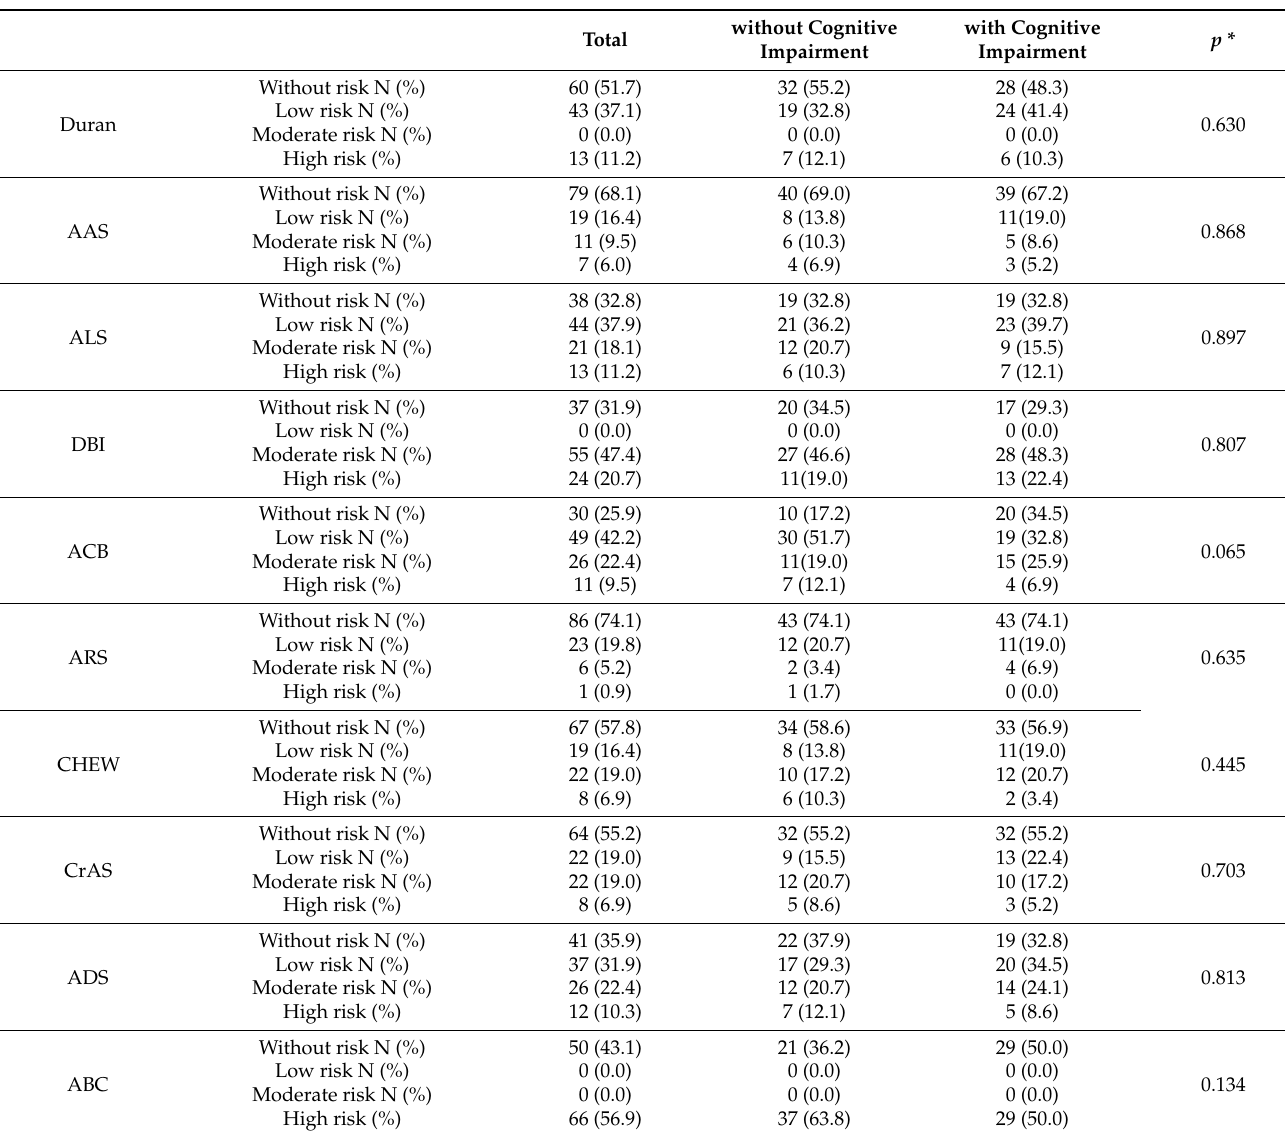
Table A8. Anticholinergic risk by all the scales in subgroups of patients evaluated on 6–9 months, with and without cognitive